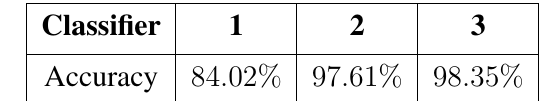
Table 2: Validation Accuracy for Single-label Classification